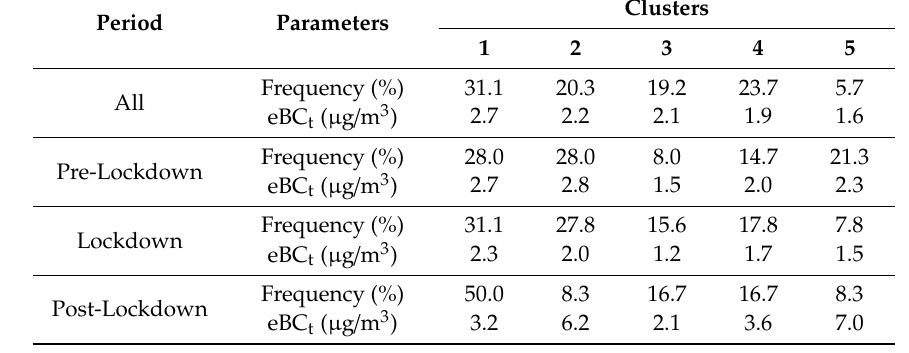
Table 3. Cluster statistics of backward air mass trajectories.